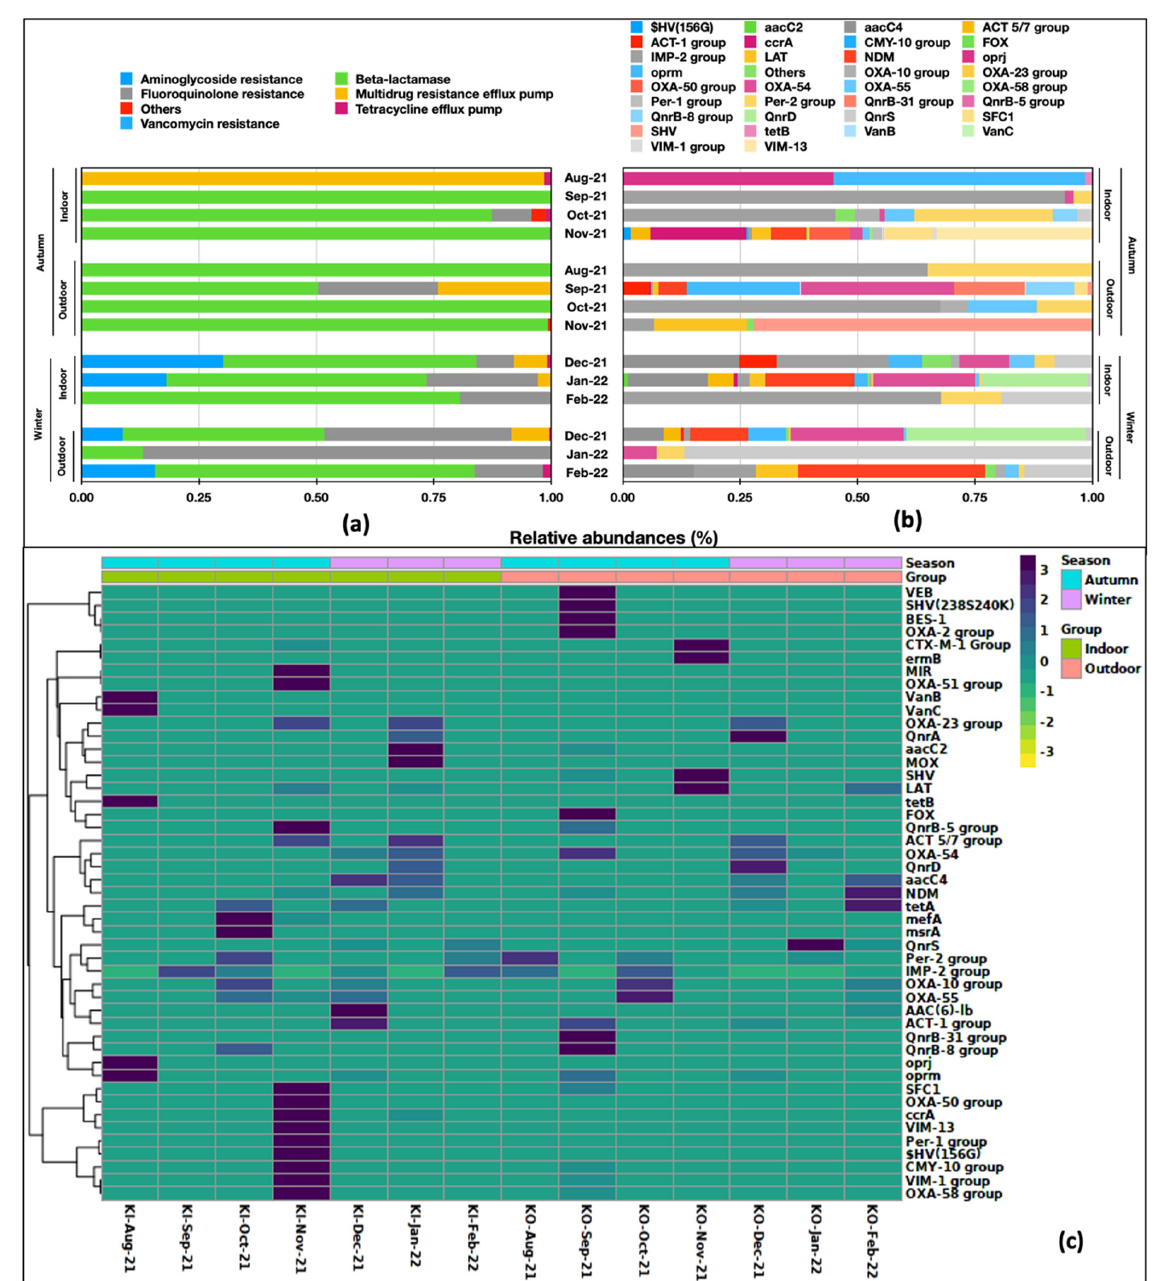
Figure 3. Spatio-temporal variation in relative abundances of: ( a ) drug classes and ( b ) ARGs present in aerosols. ( c ) Hierarchical clustering on Bray Curtis distances.